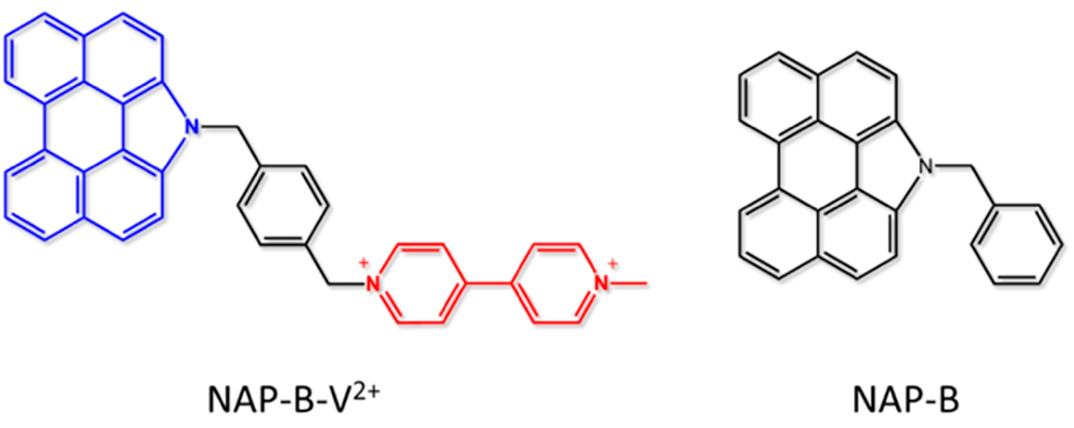
Figure 4. ( left ) D-B-A system constituted by a N-annulated perylene subunit as donor (NAP), an aromatic central moiety used as a bridge (B), and a methylviologen derivative as acceptor (V 2+ ); ( right ) NAP-B model compound.